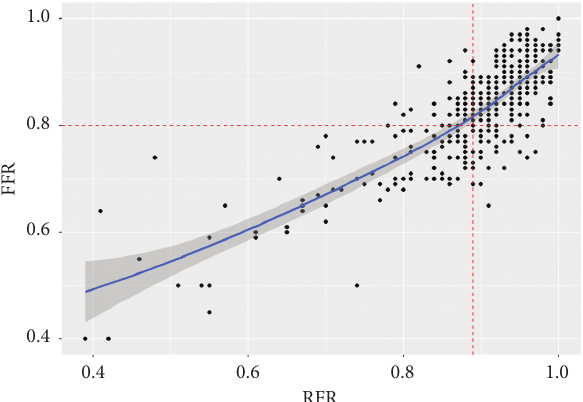
Figure 2: Distribution of the lesions according the RFR and FFR for the recommended cut-off points (RFR ≤ 0.89 and FFR ≤ 0.80). The RFR and FFR values showed a significant correlation ( R 2 � 0.81; P < 0 . 001). For the recommended cut-off points of the RFR ( ≤ 0.89) and FFR ( ≤ 0.80), the following values were obtained: diagnostic